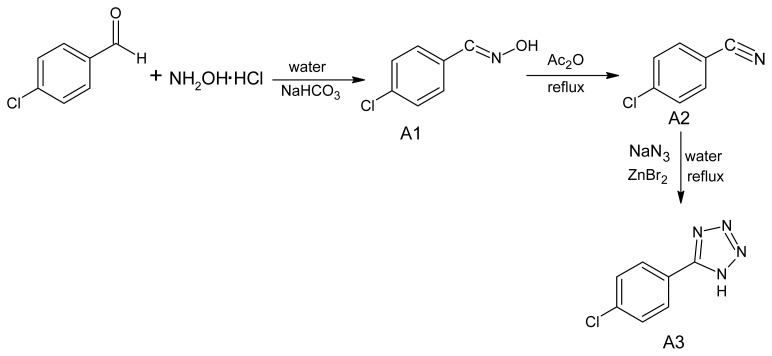
Synthesis of 5-(4-chlorophenyl)-1H-tetrazole (A3).